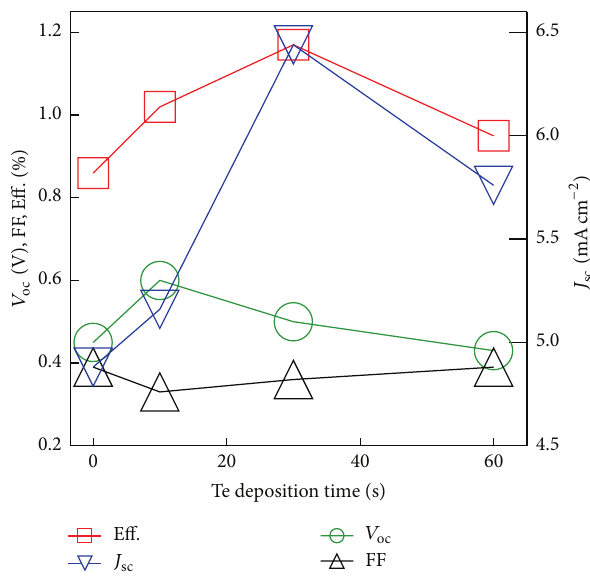
Figure 8: Variations of photovoltaic characteristics with duration of tellurium electrochemical deposition: open-circuit photovoltage ), short-circuit photocurrent density ( J ( 𝑉 oc photoenergy conversion efficiency ( 𝜂